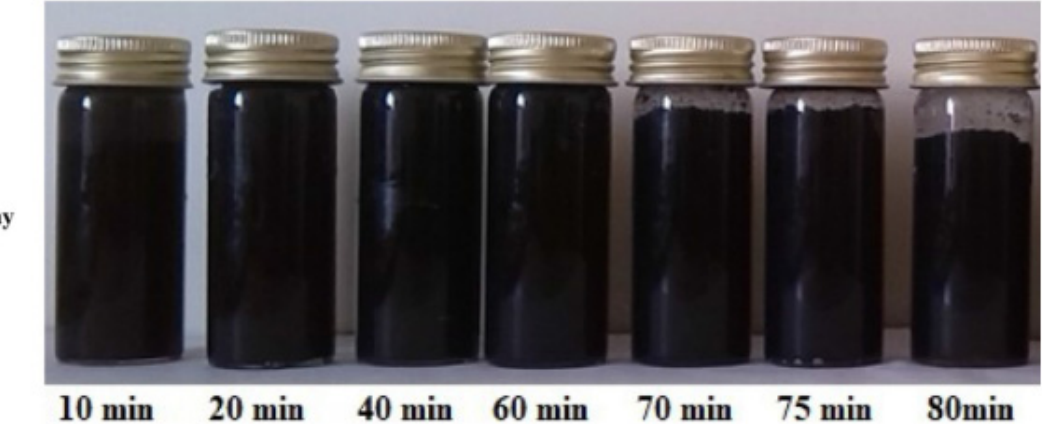
Figure 12. Stability of MWCNT-water NFs formulated at different ultrasonication durations (30 days). Adapted from [136].